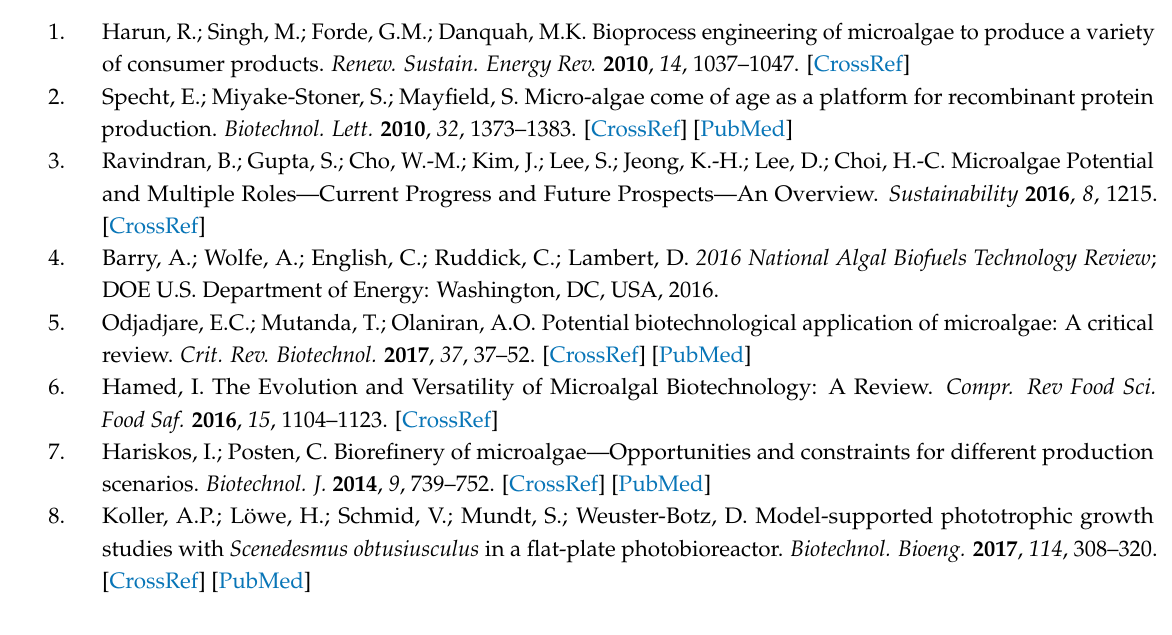
Figure S1: Light microscopy pictures of the microalgae, Figure S2: Separation efficiency in the pH range of 4 to 10, Figure S3: Separation efficiency at different pHs and 500 mM NaCl, Figure S4: Separation efficiency at different pHs and 100 mM NaCl, Figure S5: Separation efficiency at different pHs and 50 mM NaCl, Figure S6: Temperature influence on the separation efficiency of S. ovalternus , Figure S7: TEM picture of S. ovalternus after recovery from the BIONs using deionized water, Figure S8: Fractions of the HGMS process with 1 L microalgae suspension, 0.5 g BION /g microalgae , pH 4, Figure S9: Dry mass of the fractions in dependence of the process volume for the HGMS process with 5 L microalgae suspension, 0.5 g BION /g microalgae , pH 6.75, Figure S10: In-situ cultivation experiments with 85 mL Saccharomyces cerevisiae in